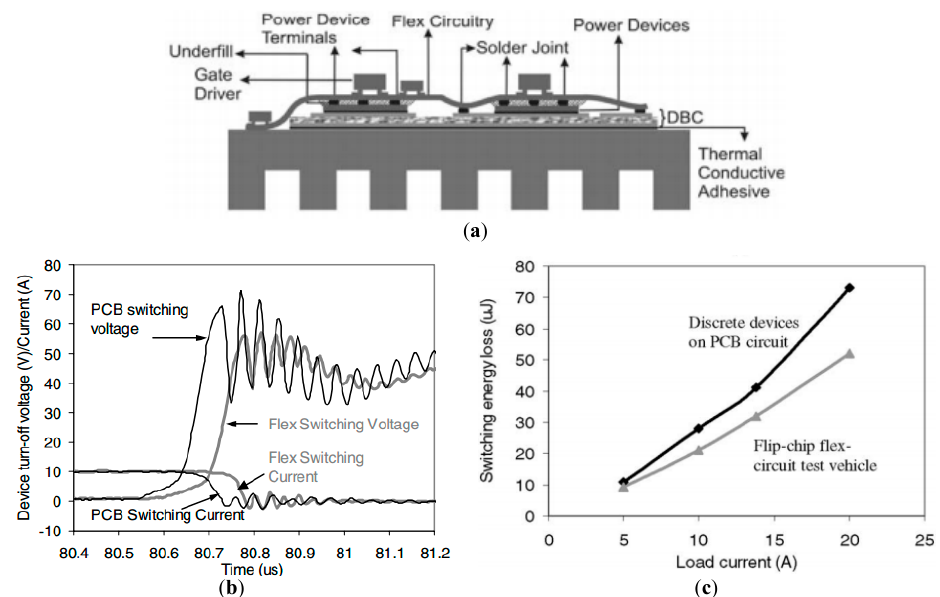
Figure 11. Flip-chip on flex package showing ( a ) a schematic of the package cross-section; ( b ) the experimental waveforms showing a reduction in the turn-off transients; and ( c ) the reduction in